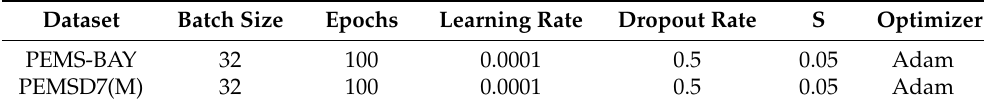
Table 2. Optimal hyper-parameter settings for training our proposed